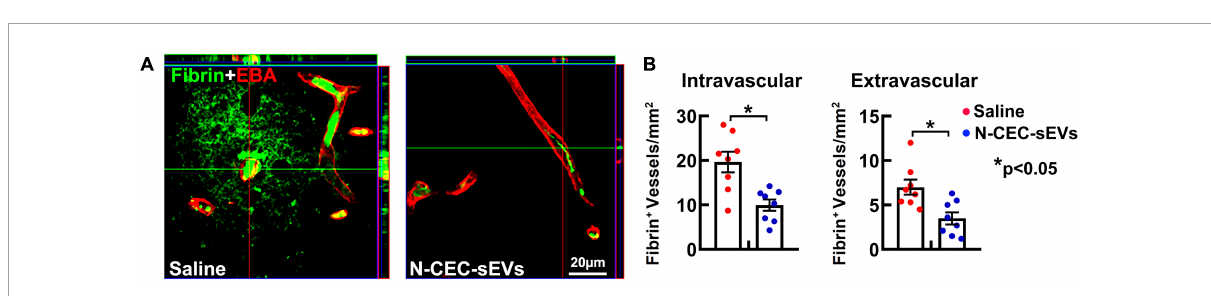
FIGURE5 N-CEC-sEV treatment reduces cerebral vascular damage. Representative confocal microscopic images (A) and quantitative data (B) of fibrin/fibrinogen immunoreactivity (green) in the hippocampus of aged-DM rats treated with saline or N-CEC-sEVs. * p < 0.05 versus indicated groups.